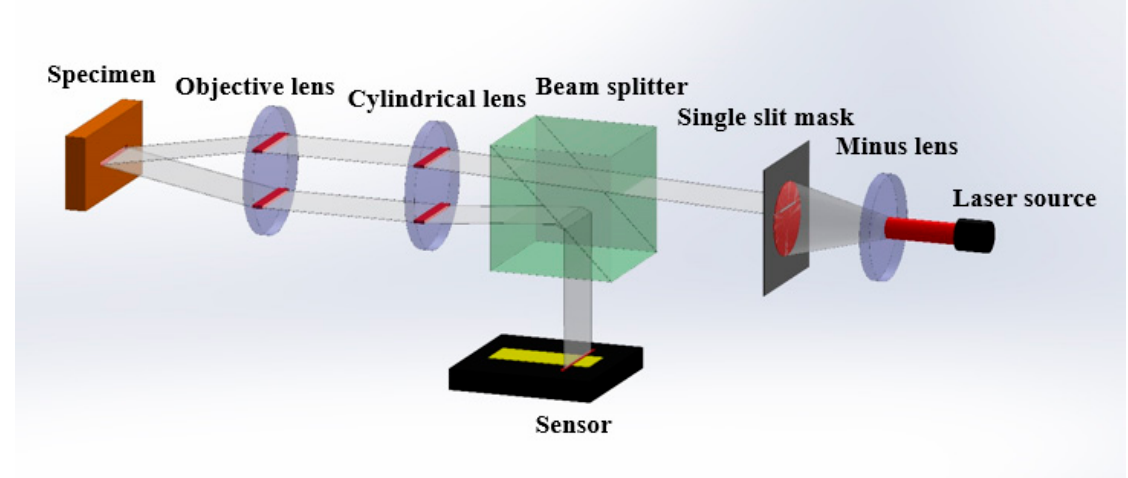
Figure 5. Schematic of the experimental setup.